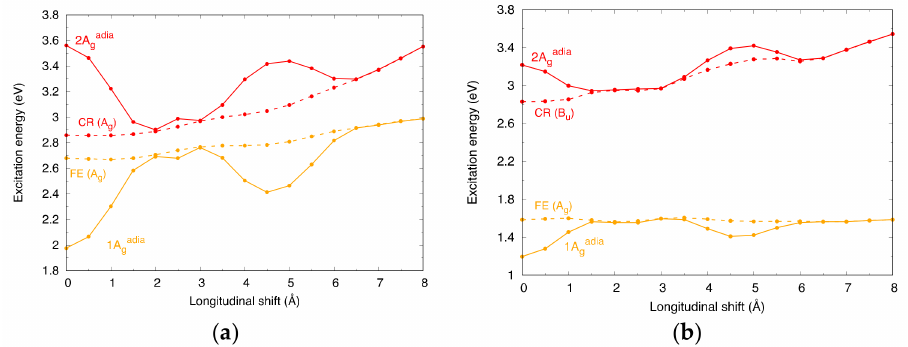
Figure 5. Energy profiles (TDA- ω B97X-D/6-31G ∗ ) of (solid) A g adiabatic exciton states and (dashed) A g FE and CR states for the PDI dimer along the longitudinal translation coordinate: ( a ) singlet exciton states; ( b ) triplet exciton states. The computed exciton energy profiles result from the interactions between CR and FE states of the same symmetry. When the interactions (Figure 4b) are strong, the exciton-state energies deviate from FE and CR energies. The interaction is less effective for triplet states due to the larger energy difference between FE and CR